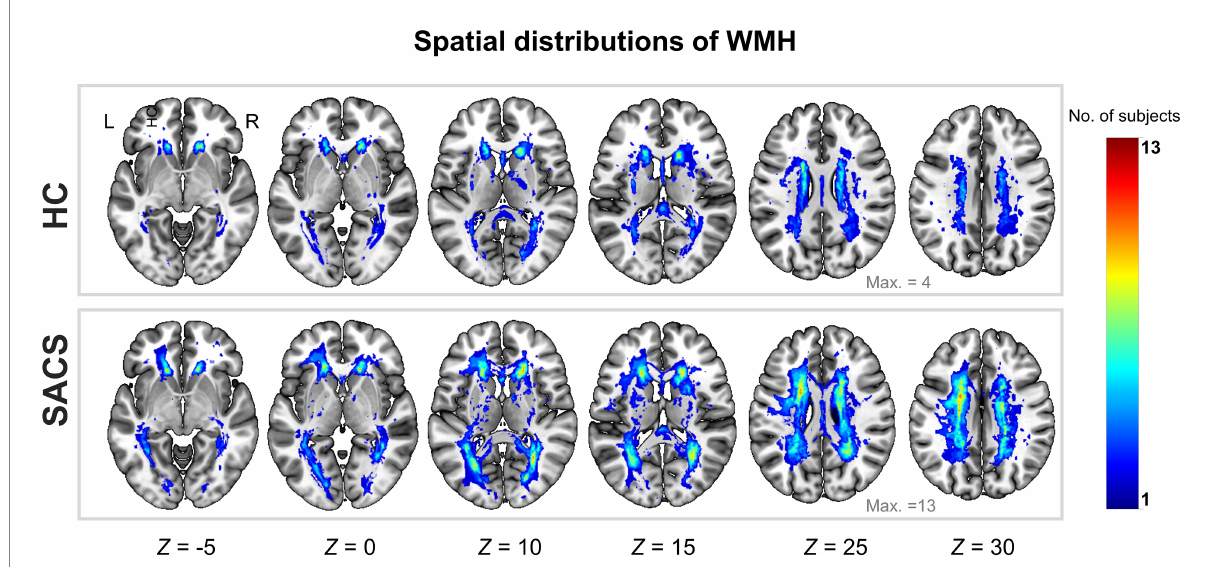
FIGURE 2 Probability map of WMH lesions. Spatial distributions of cumulative WMH for the control group (upper panel) and patients with SACS (lower panel). The colorbar indicates the number of subjects who had WMH in the same voxel, i.e., the control group had a maximum of 4 subjects overlapping in the same voxel, while the SACS patients had a maximum of 13 subjects overlapping in the same location. L, left; R, right; WMH, white matter hyperintensity; SACS, severe asymptomatic carotid stenosis; HC, healthy